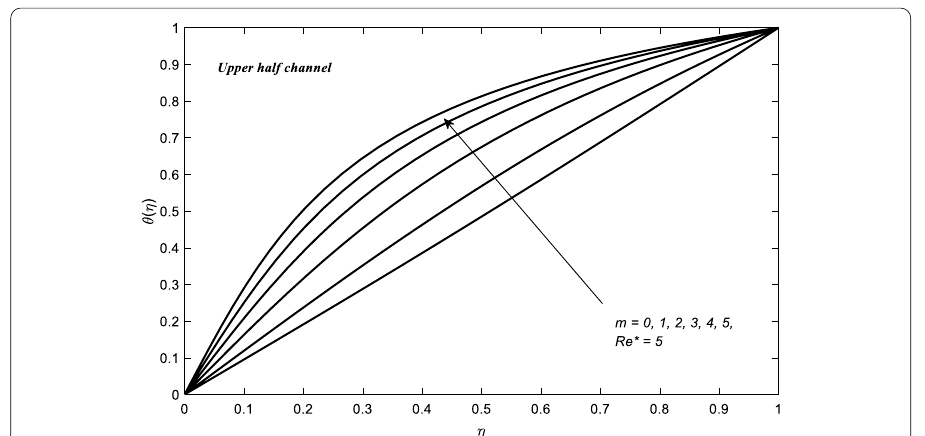
Fig. 9 Diverging channel: The dimensionless temperature distribution ( θ ) in upper channel is graphed 0.1 and Pr 1 against η for c 1 = =